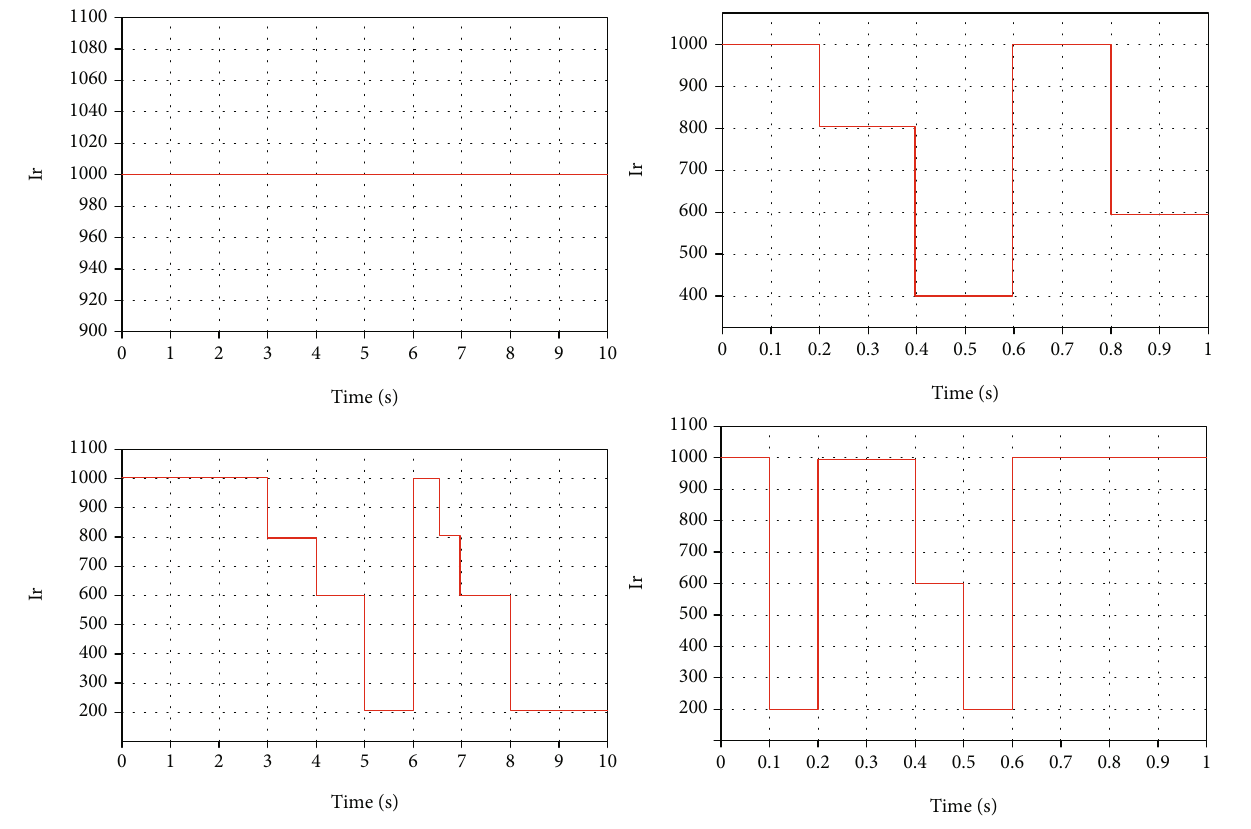
Figure 6: Di ff erent pro fi le of irradiance and at fi xed temperature at 25 ° C pattern for the